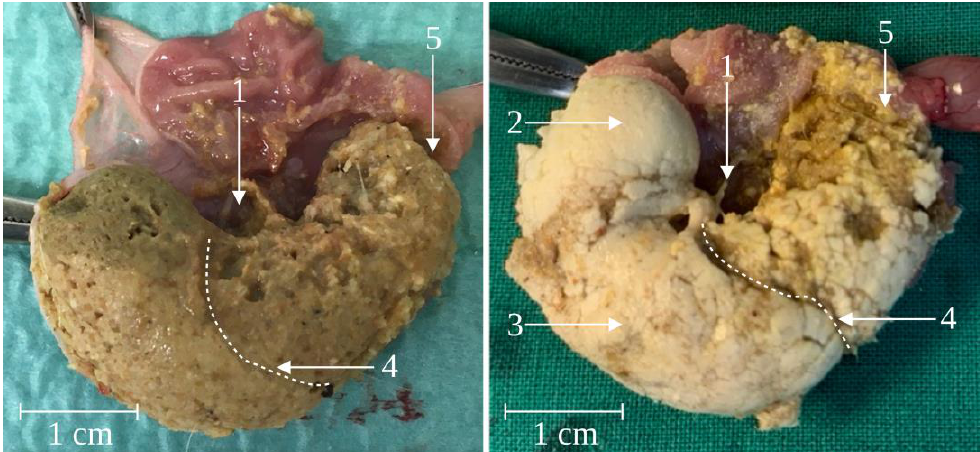
Figure 5. Ex vivo opened rat stomach of a female rat without pharmacobezoar ( left ) and of a rat from group DF 1 with pharmacobezoar ( right ) (1 — cardia, 2 — major solid pharmacobezoar with small hole at the upper left side, 3 — non-rigid SD-ASD particles, 4 — limiting ridge, 5 — pylorus).